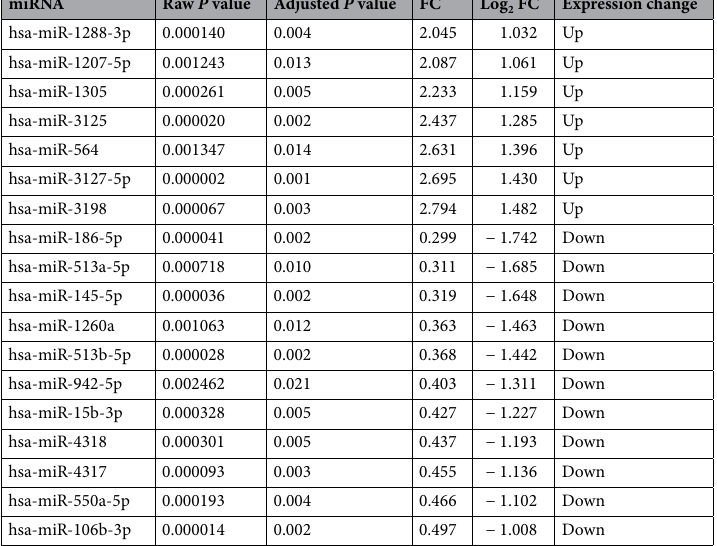
Table 5. The miRNA expression determined by miRNA microarrays. FC fold-change.